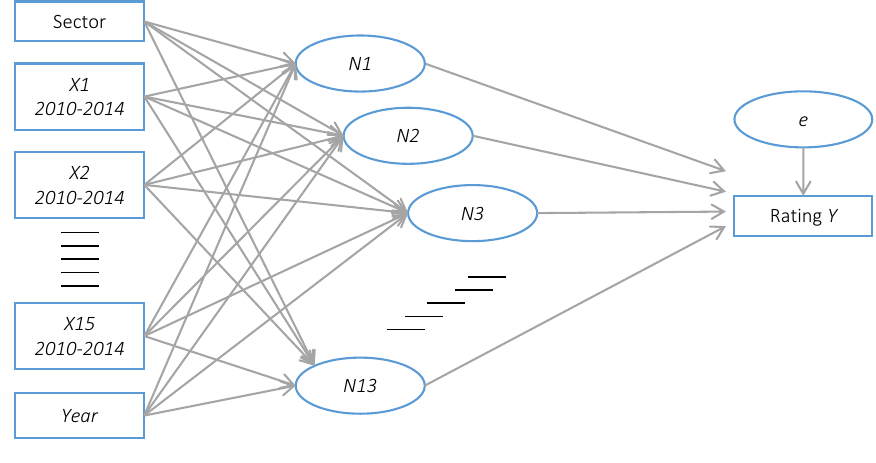
Figure 5. Network MLP (47, 13, 1) to estimate S&P rating